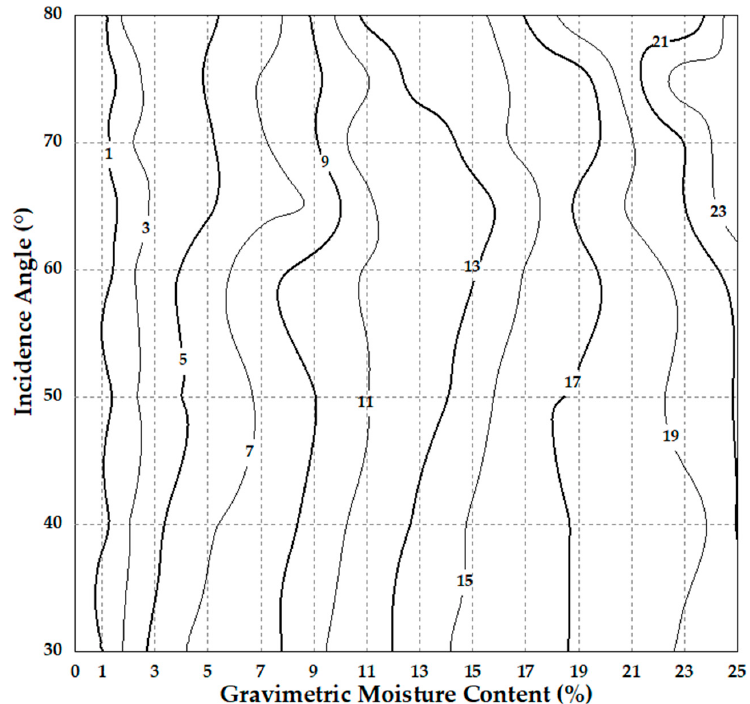
Figure 6. Contour lines of the derived moisture versus the incidence angle (30–80°) and the gravimetric moisture contents (0–25%) based on the incidence angle experiments. Table 3. Derived samples’ moisture contents based on the incidence angle experiments. Moisture